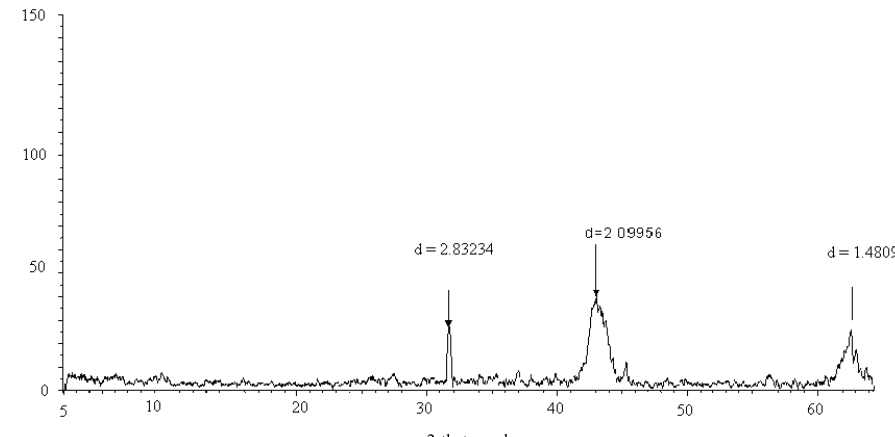
Figure 2b . The diffraction spectra of the calcinated STH -500.